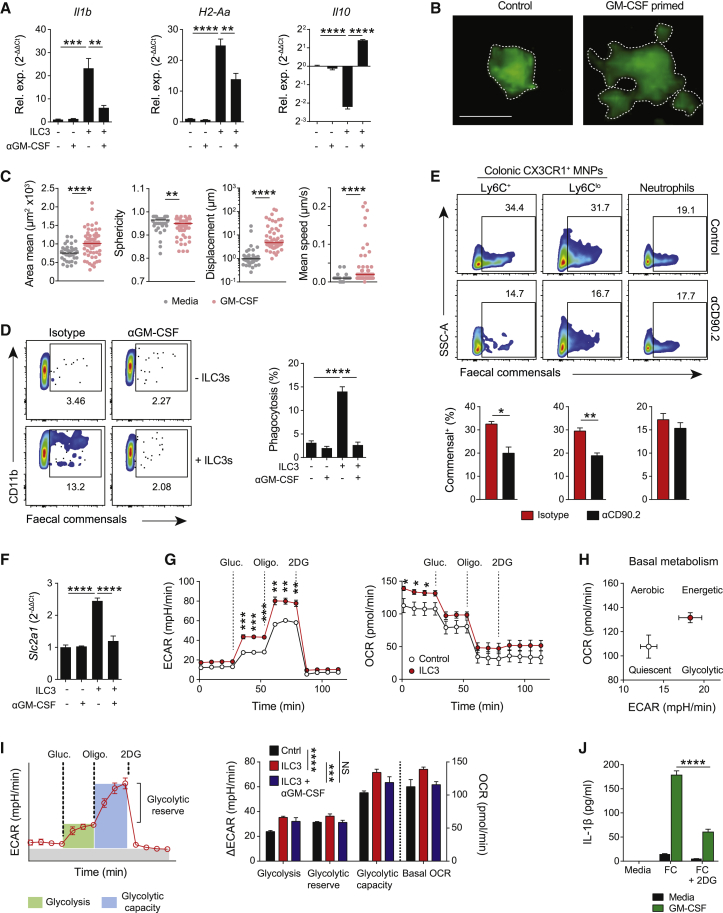
ILC3-Derived GM-CSF Regulates MNP Microbicidal Activity and Metabolism(A) Cytokine and MHC-II expression in BMDMs cultured with ILC3s ± isotype or anti-GM-CSF IgG for 16 h. Mean ± SEM indicated from triplicates.(B and C) Morphology and motility analysis of BMDMs after 48 h culture ± control or GM-CSF-supplemented media. Medians are indicated. Scale bar, 10 μm.(D and E) Phagocytosis of fluorescent commensal microbes by BMDMs co-cultured as in (A) for 72 h (D) or by colonic MNP subsets and neutrophils from mice treated with isotype or anti-CD90.2 IgG at day 6 post 2% DSS administration (E). Mean ± SEM indicated from triplicates.(F) Slc2a1 expression in BMDMs co-cultured as in (A). Mean ± SEM indicated from triplicates.(G) ECAR and OCR for BMDMs primed with ILC3-conditioned media compared to control media for 16 h. Mean ± SEM indicated from 6 measurements.(H) Basal metabolic profile of BMDMs in (G). Mean ± SEM indicated.(I) Analysis of features of glycolytic metabolism in BMDMs cultured as in (G) ± anti-GM-CSF IgG. Mean ± SEM indicated from 6 measurements.(J) IL-1β production by BMDMs primed with GM-CSF or control media for 16h before stimulation with fecal commensals (FC) and 2DG for 6 h.Mean ± SEM indicated from triplicates. Data are representative of two (D, E, and G–J) or three (A, B, and F) independent experiments. p values were calculated using a one-way ANOVA with Tukey’s multiple comparisons test (A, D, and F), Mann-Whitney U test (C), Student’s t test (E), multiple t tests with Holm-Sidak’s multiple comparisons test (G), and two-way ANOVA with Tukey’s multiple comparisons test (I and J). ∗p < 0.05; ∗∗p < 0.01; ∗∗∗p < 0.001; ∗∗∗∗p < 0.0001. See also Figure S5.